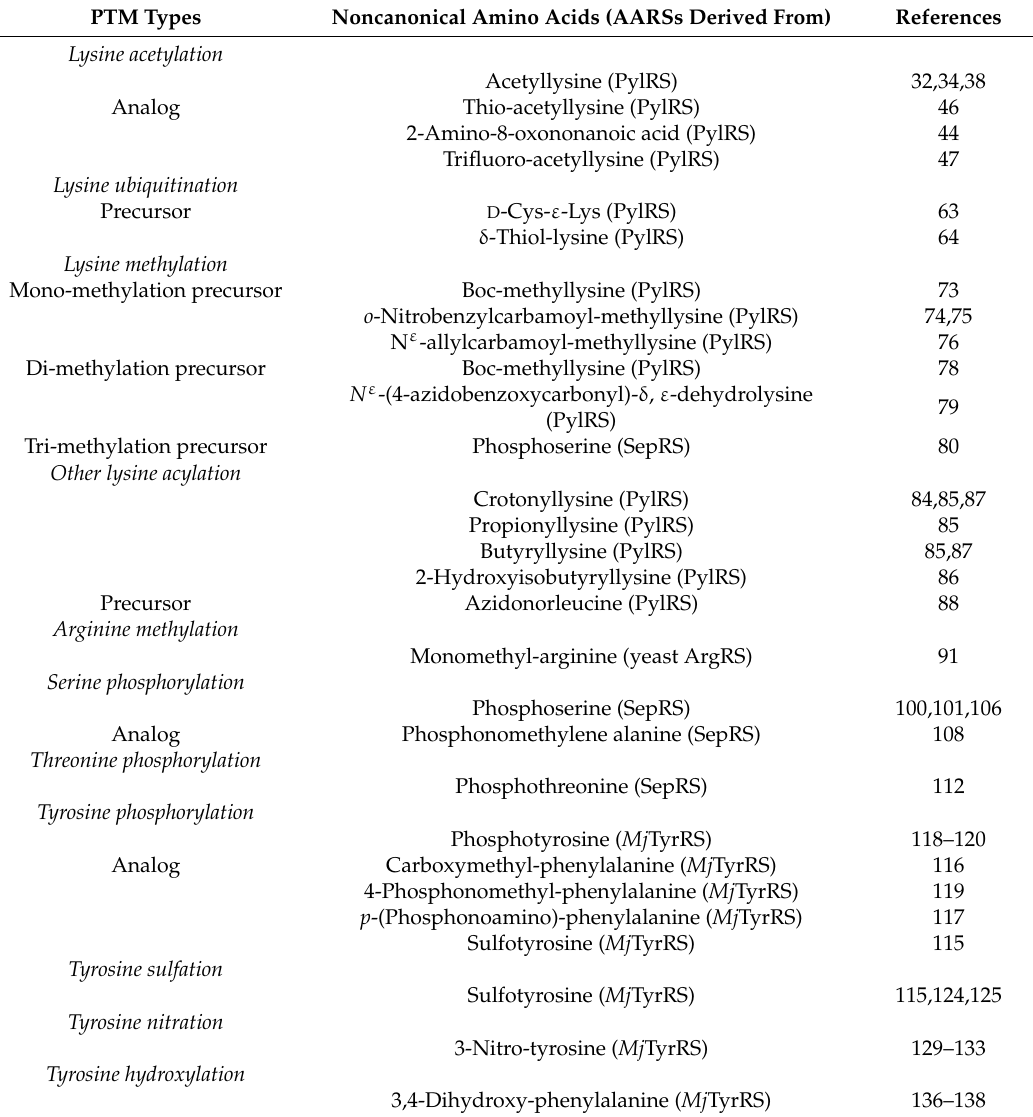
Table 1. An index of genetic incorporation systems for PTM